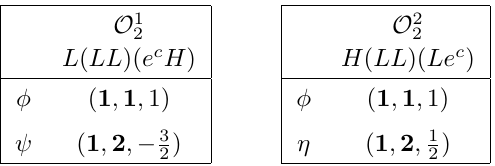
Table 2 . Minimal UV completions of operator [31]. Here (cid:30) and (cid:17) generically denote scalars and O 2 is a generic vectorlike fermion. The SM quantum numbers of these new (cid:12)elds are as indicated.